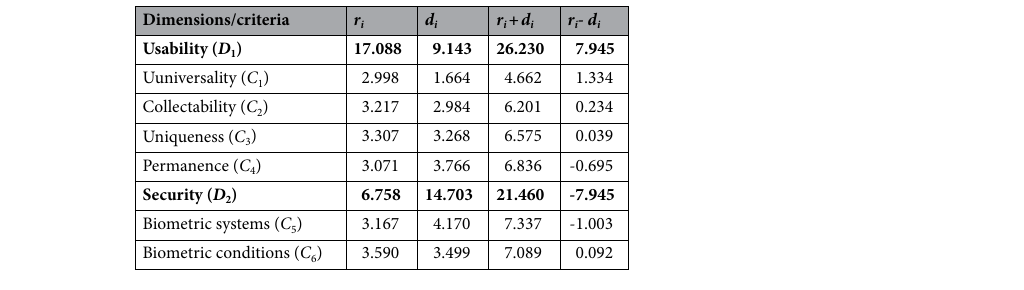
Table 4. The sum of influences giving and